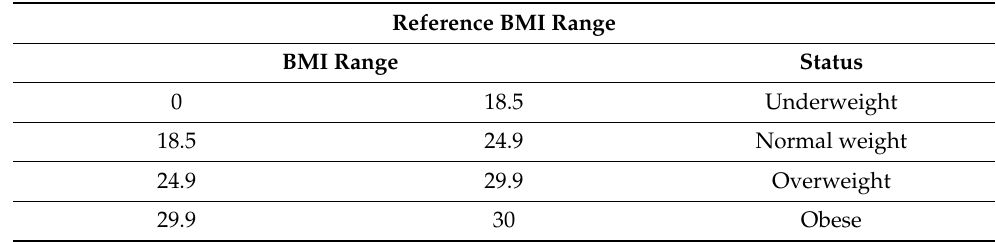
Table 1. Reference standard Table for BMI calculations.